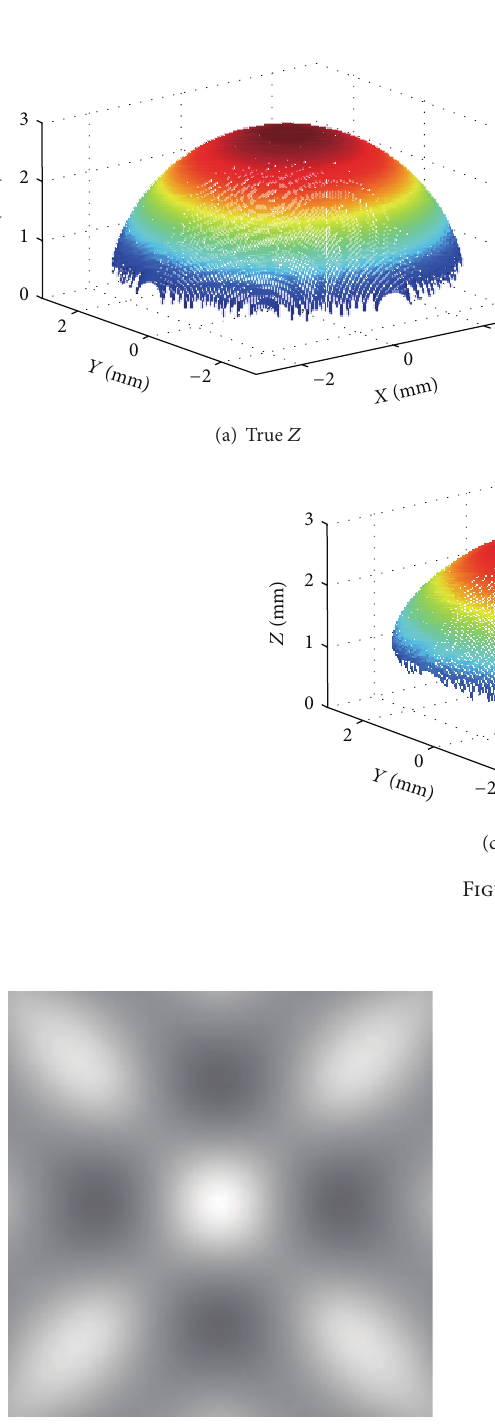
Figure 8: Cosine